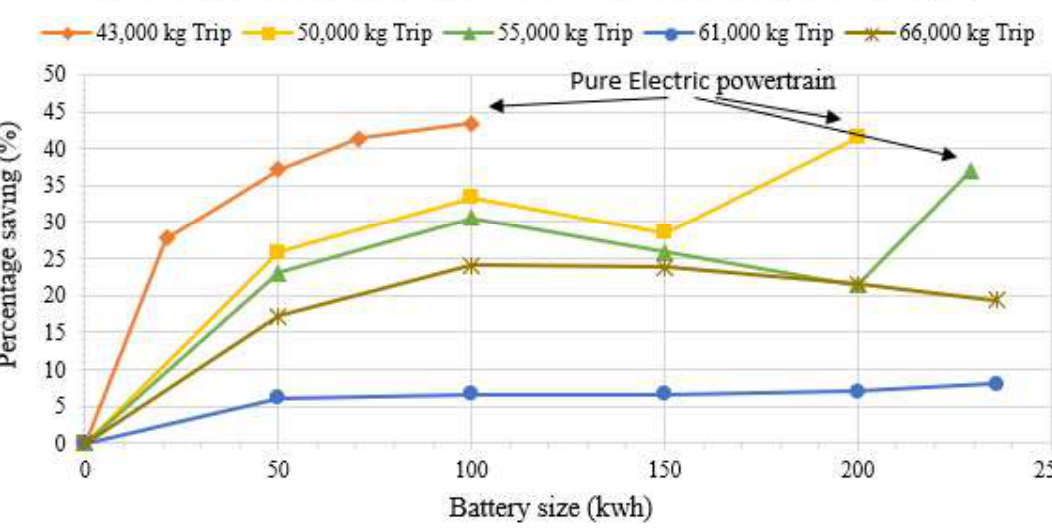
Figure 14. Percentage saved over operating with diesel power train alone.